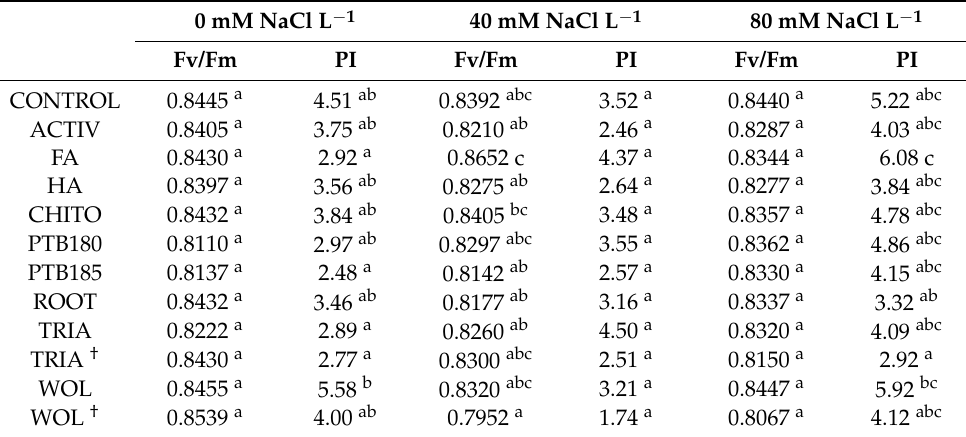
Table 8. Effect of biostimulants and salinity levels on the chlorophyll fluorescence parameters (variable fluorescence/maximum fluorescence (Fv/Fm) and performance index (PI)) of baby leaf lettuce plants under organic management.